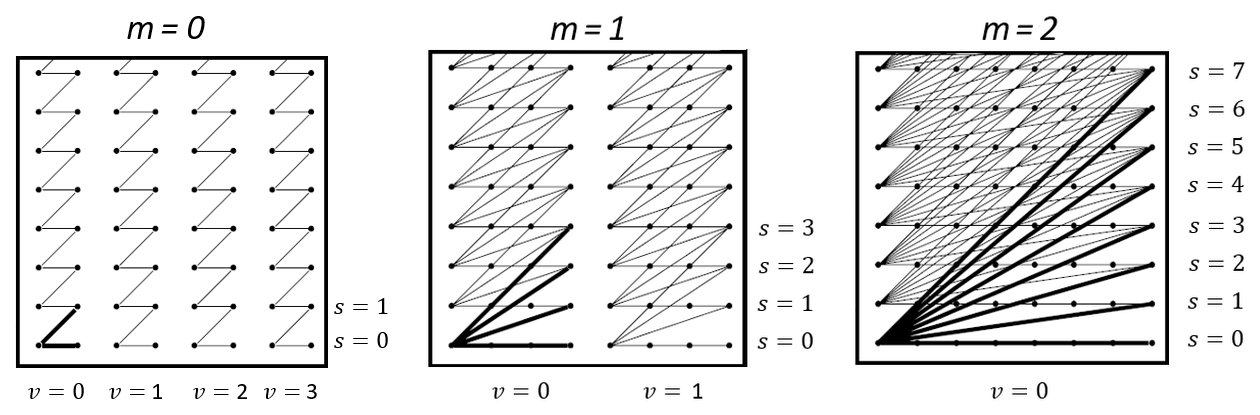
Figure 1. Depiction of partial transforms of multiscale DRT. As the stage increases, the vertical bands decrease, and the slopes become more